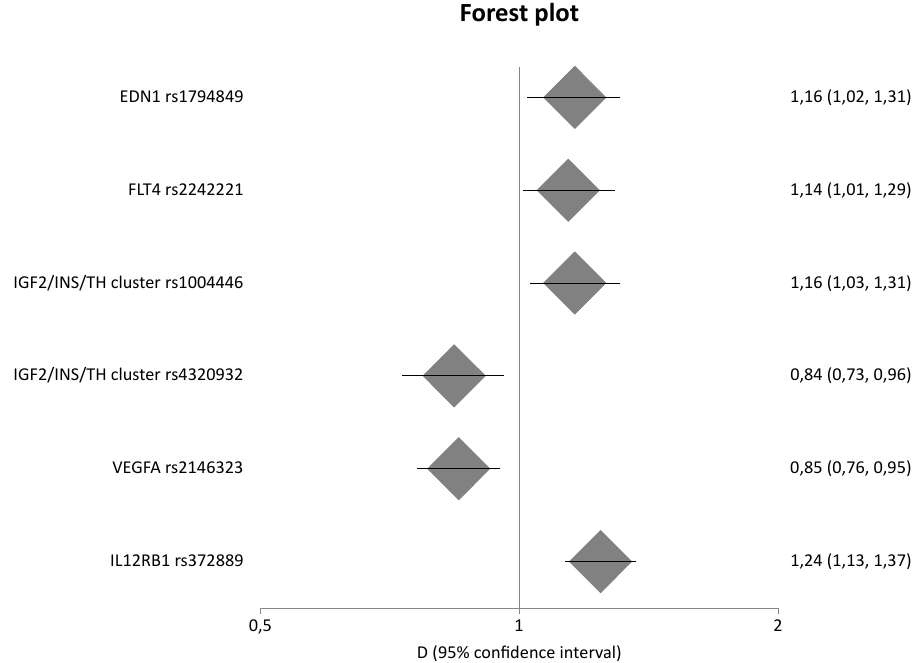
Figure 5. Meta-analysis results of healthy controls versus diseased controls versus cases based on genotype counts.